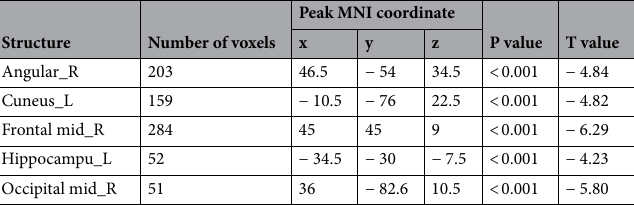
Table 4. Areas of decreased GM volume (p < 0.001) in Meige syndrome patients with and without